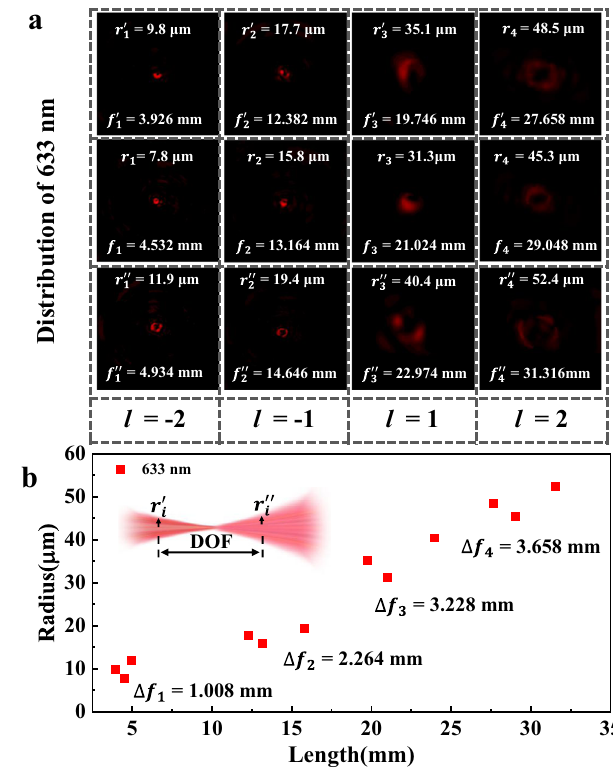
Fig. 4 | Experimental focal spots, radii, and the DOF of the VDM at 532nm. a Collected fi eld distribution, focal length, and radii of 532nm for adjacent four focalplaneswiththeOAMof − 2, − 1,1,and2. b Depictofthestatisticalresultsforthe focal length, radii, and the DOF of the focal point for